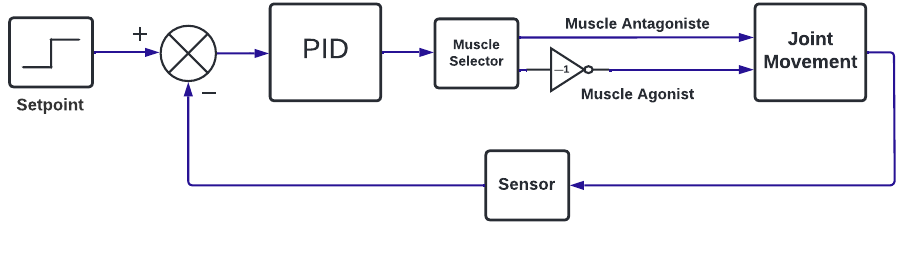
Figure 4. PID Block